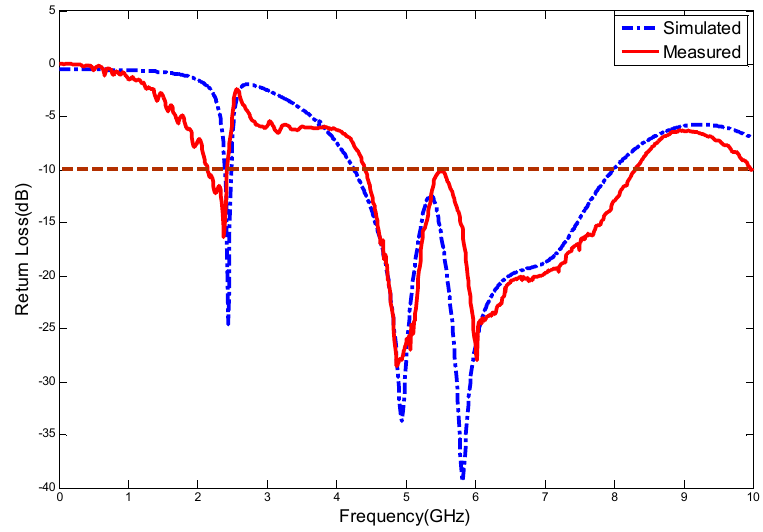
Figure 13. Simulated and measured return loss of the proposed antenna.